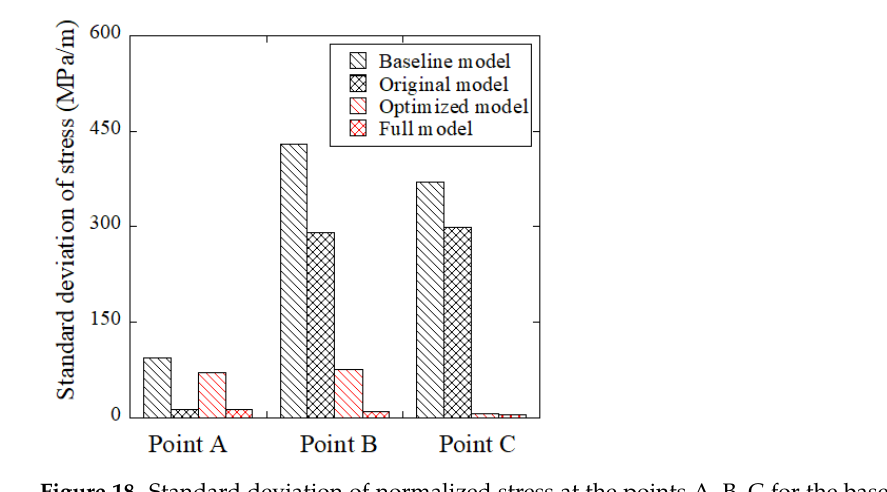
Figure 18. Standard deviation of normalized stress at the points A, B, C for the baseline, original, optimized and full models in the irregular wave ( H = 0.195 m, T = 2.16 s).